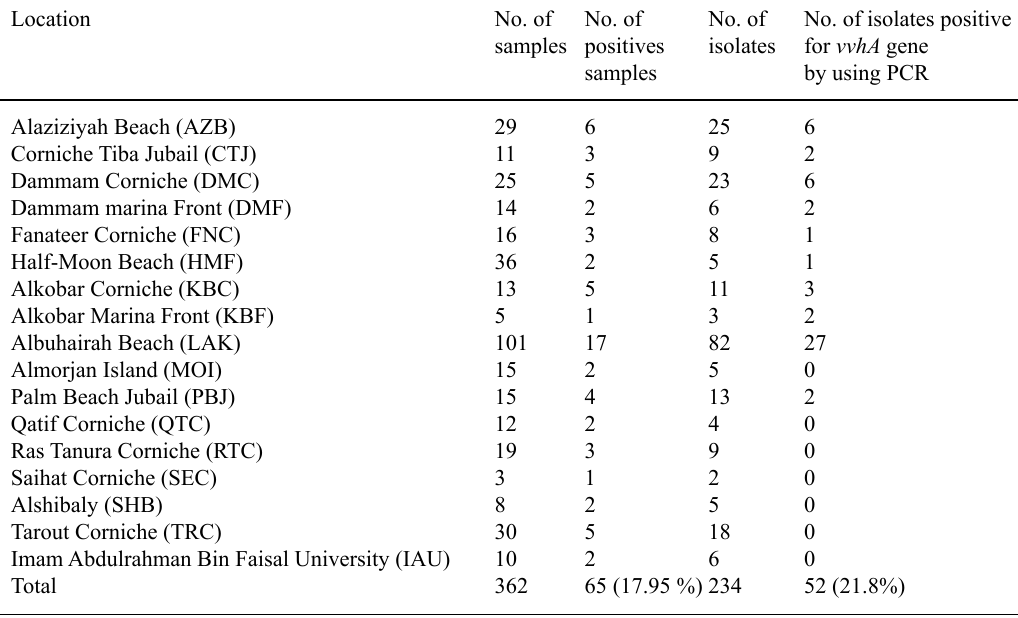
Table 1. Total number of seawater samples and V. vulnificus isolates recovered from different locations Location No. of No. of No. of No. of isolates positive samples positives isolates for vvhA gene samples by using